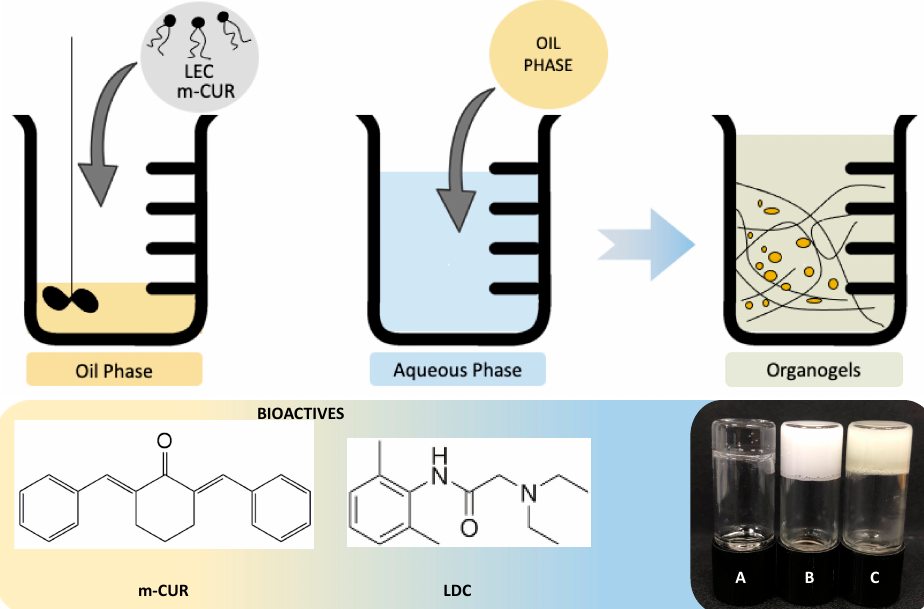
Figure 2. PL-based organogels preparation scheme. Inserted pictures below show ( A ) PL407 hydrogel, ( B ) PL407 + IPM organogel (ORG), and ( C ) m-CUR-loaded PL407 + IPM ORG.